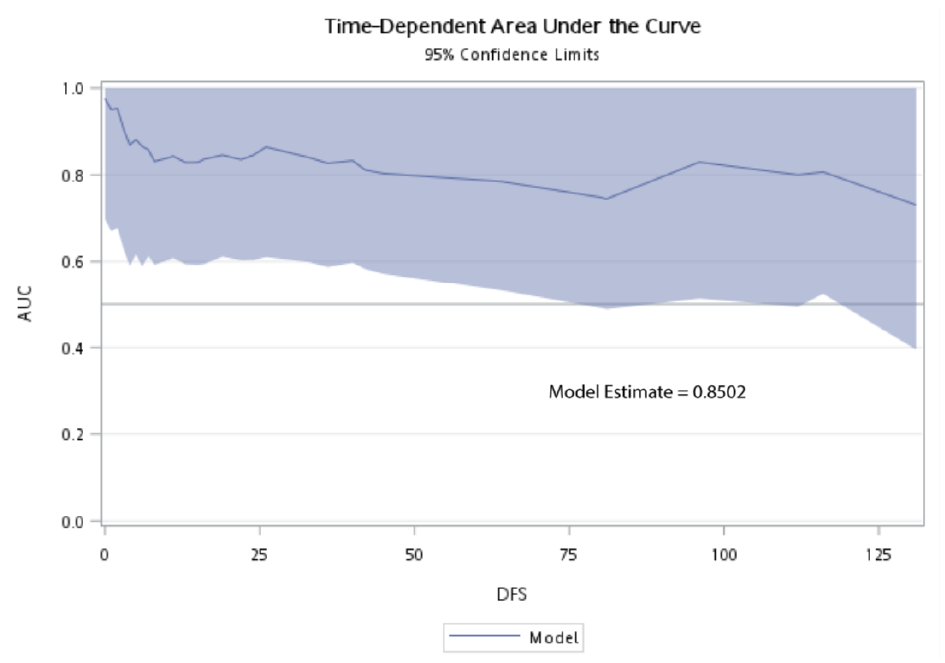
Figure 3. Harrell’s concordance statistics and time-dependent area under the curve for disease free survival (DFS) for pre- and post-treatment model.